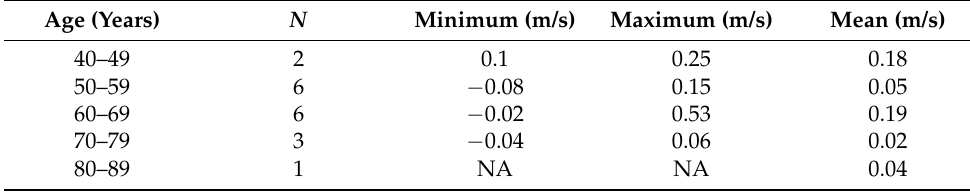
Table 3. Change in gait speed across pre- and post-intervention time points by age.